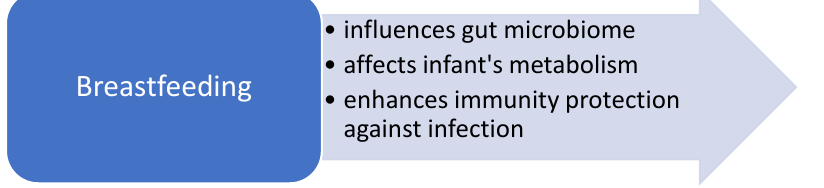
Figure 2. Proposed mechanism of action of breastfeeding in asthma primary prevention.